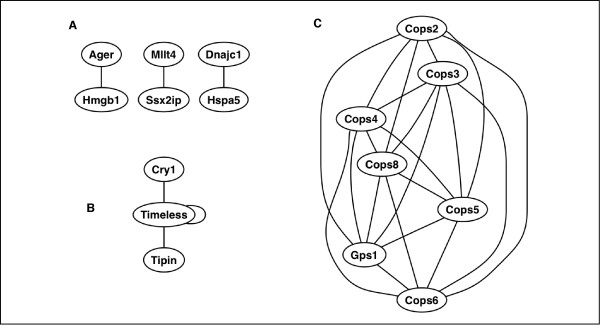
Selected interaction maps from Figure 3.